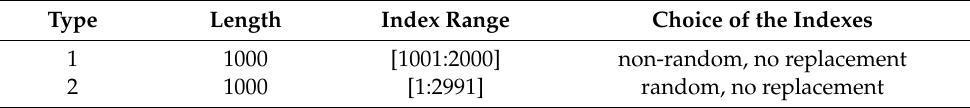
Table 5. Characteristics of training datasets subset, built-up from “true”